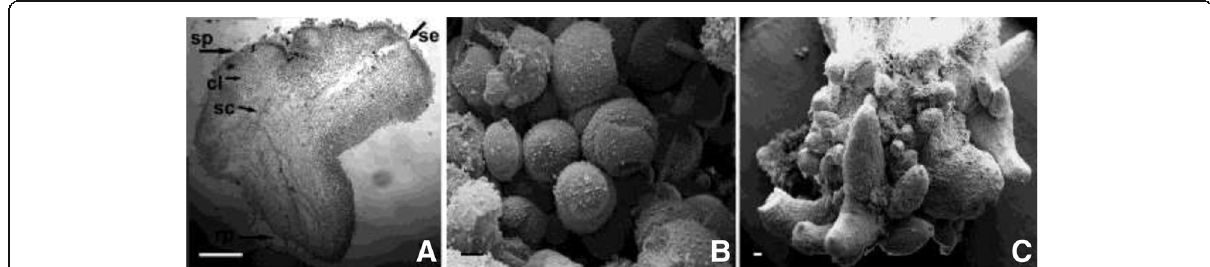
Fig. 2 Histology and SEM of somatic embryos. a L.S. of somatic embryo revealing a primary somatic embryo (pe) with shoot pole (sp) and root pole (rp). A secondary embryo (se) is arising from the body of the primary embryo. Note the coleoptile (cp) and scutellum (sc). (bar 0.42 mm). b , c SEM of somatic embryos. b globular embryos; note the distinct dome-like structures with smooth epidermal surface ( c ) bipolar embryo. Note the characteristic mesh-like epidermal surface (bar 30 μ m, 200 μ m, respectively)